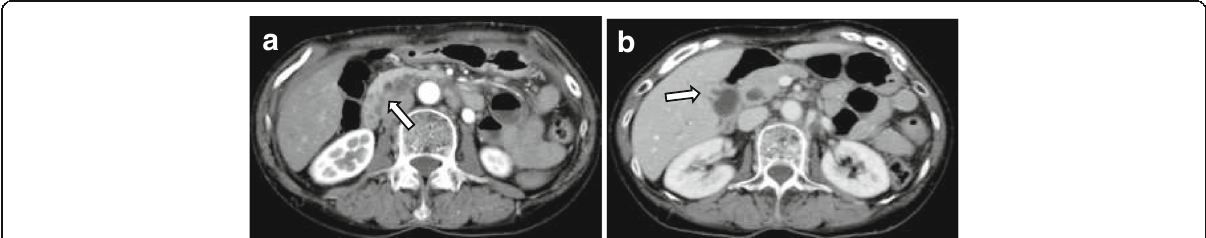
Fig. 1 Abdominal computed tomography (CT). a Low-density mass and cystic lesions in the pancreatic head. b Thickness in the wall adjoining the bottom of the